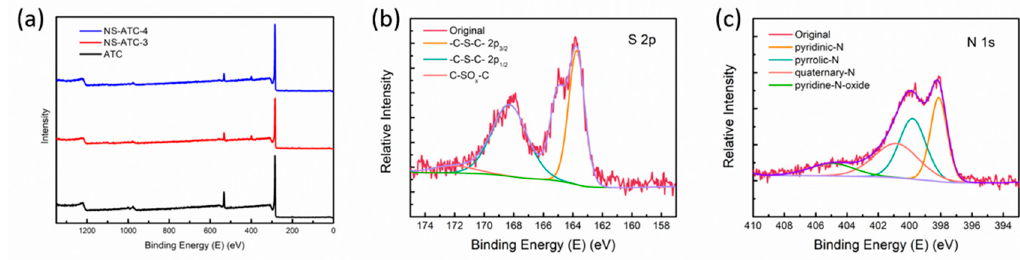
Figure 5. ( a ) XPS spectra of samples before and after N, S-codoping; ( b ) XPS spectra of S 2p of NS-ATC-4; ( c ) XPS spectra of N 1 s of NS-ATC-4.